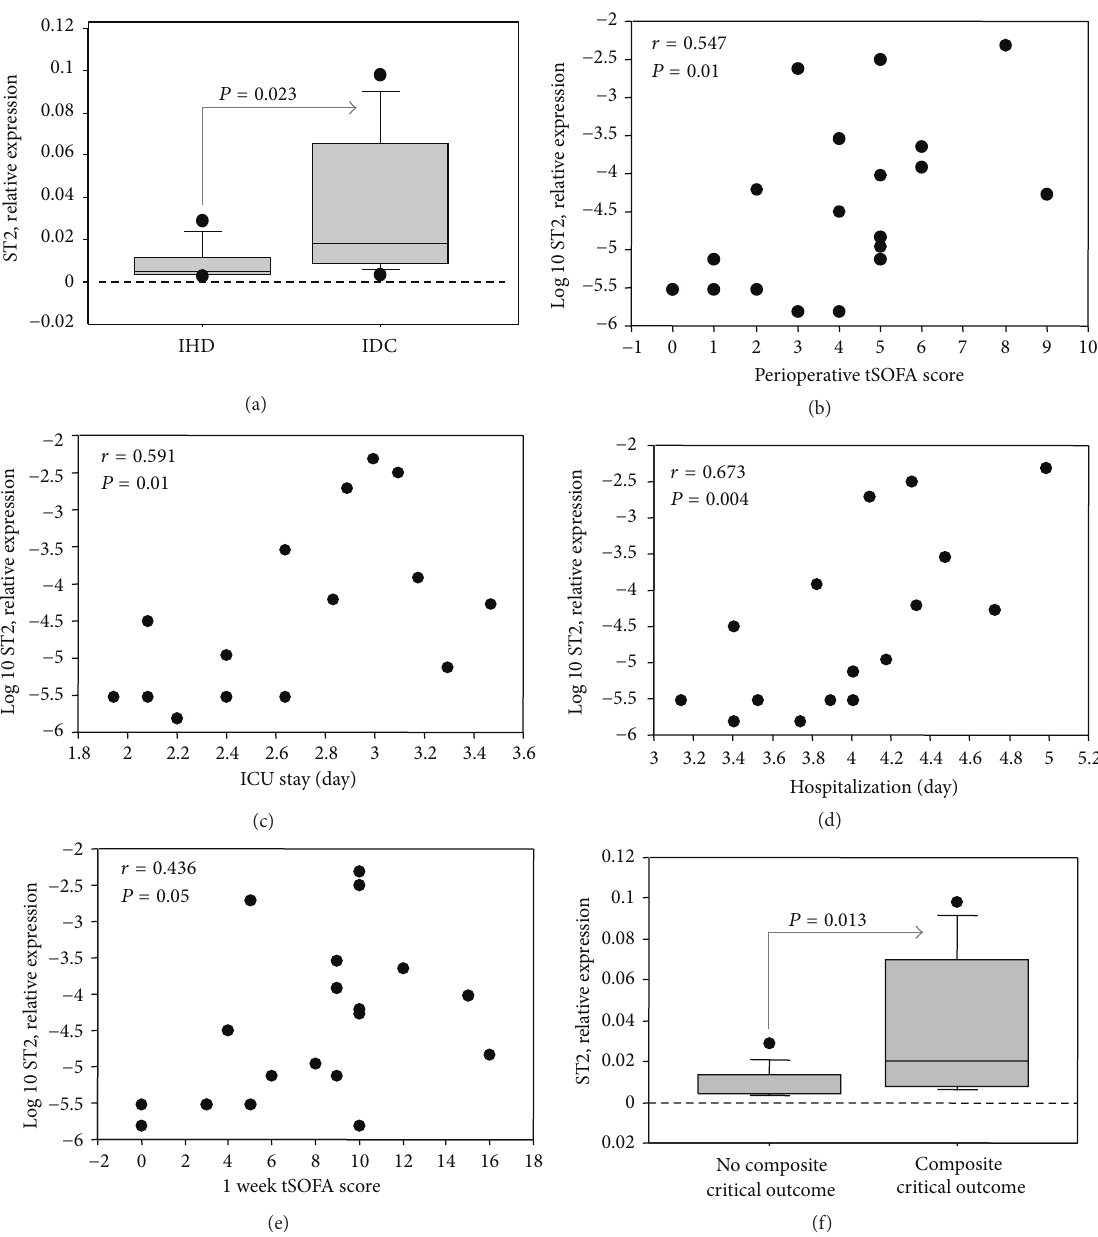
Figure 3: Relation between myocardial ST2 expression and both diagnosis ((a) and (b)) and outcome ((c) and (d)) of pre-LVAD group of samples. (a) Different ST2 expression according to HF etiology; (b) correlation with perioperative tSOFA score; (c) correlation with duration of ICU stay; (d) correlation with length of hospitalization; (e) correlation with 1 week tSOFA score; (f) ST2 expression according to composite